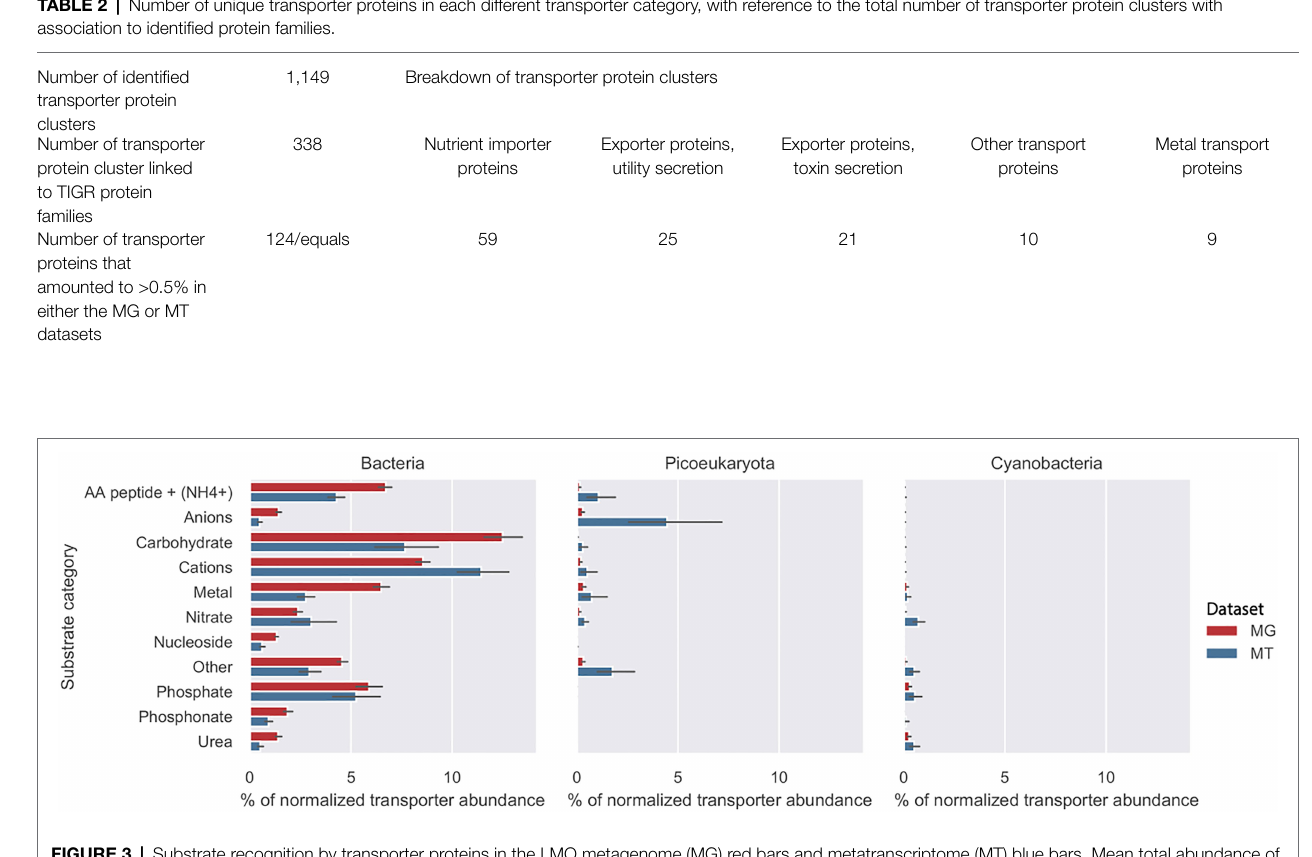
FIGURE 3 | Substrate recognition by transporter proteins in the LMO metagenome (MG) red bars and metatranscriptome (MT) blue bars. Mean total abundance of each substrate category during the 2012 growth period (10 months) for bacteria, picoeucaryotes, and cyanobacteria as a proportion of total transporter abundance. The abundance of transporter proteins genes associated with cyanobacteria was subtracted from the Bacteria